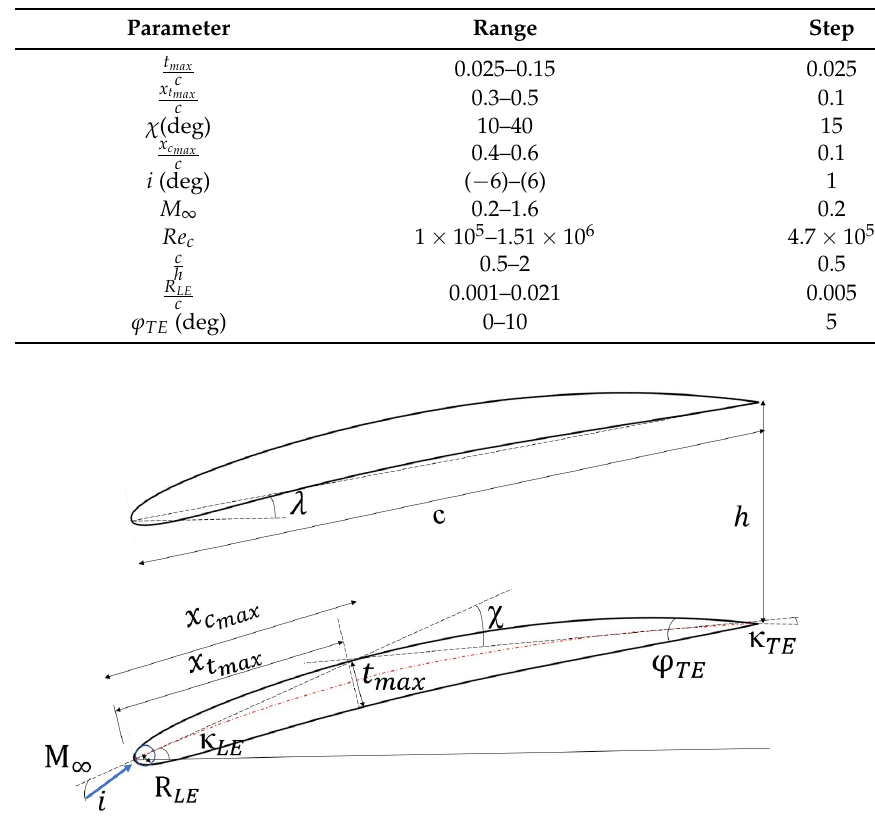
Figure 2. Schematic of geometry parameters for airfoil shape